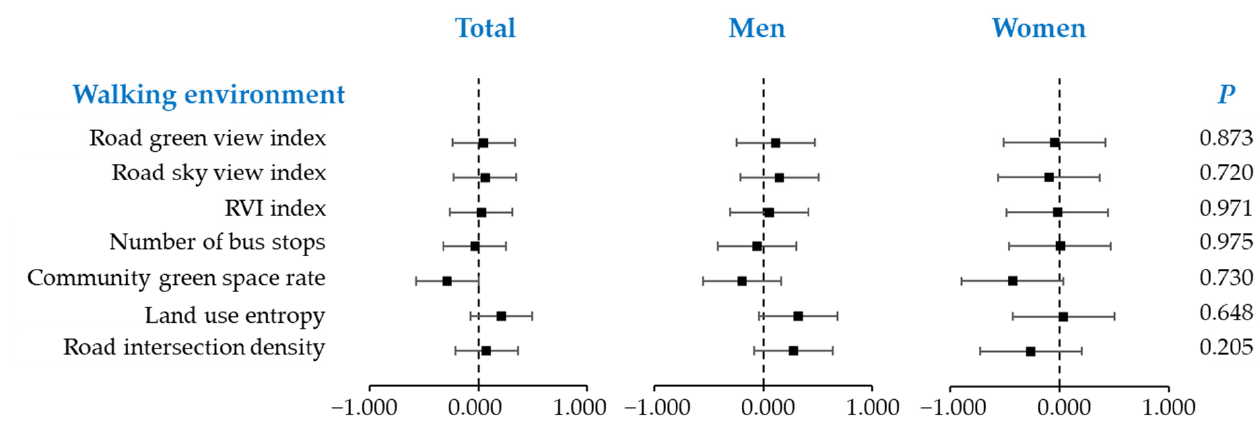
Figure 3. The heterogeneity of the built environment between men and women. We further analyzed the discrepancies between each level of walking environment (Figure 4). The quartiles are used to divide the walking environment indexes into four levels: low, lower, higher, and high. Only the RVI index of the lower and higher levels is significant ( p = 0.043), indicating that a large difference exits in the risk of obesity among residents of these two levels. Besides, more levels in the road sky view index, such as low level and higher level ( p = 0.030), lower level and higher level ( p = 0.001), lower level and high level ( p = 0.050) have significant differences, showing that different grades of streets blue space have a greater impact on the shape of the residents.